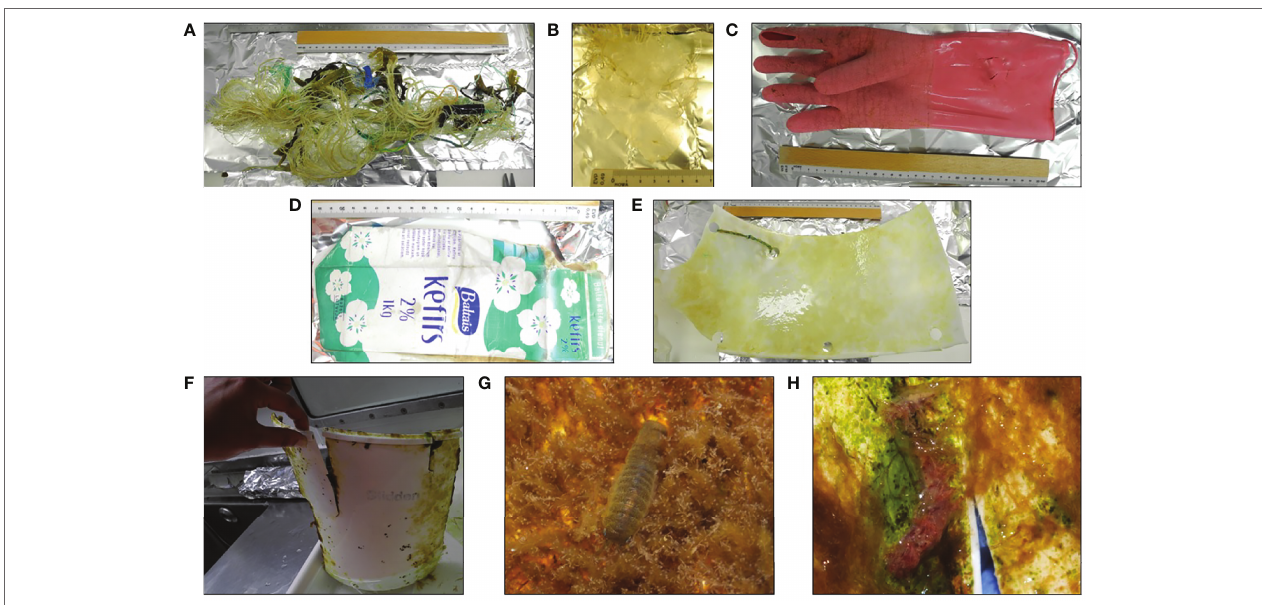
FIGURE 6 | Photographs of plastic debris hand-picked from the sea surface in Fram Strait in 2016: (A) a bundle of tangled ropes, (B) a transparent soft fragment that had been entangled with the ropes, (C) fisheries glove, (D) a Kefir Tetra Pak manufactured in Latvia, (E) bucket fragment, (F) fragment of a more than 20-year- old bucket of the paint manufacturer Glidden, a piece of a plastic box that was densely colonised by hydrozoans and algae with (G) a rafting isopod Idotea sp. and (H) a nudibranch cf. Dendronotus sp. (credit: G, H by Andrey